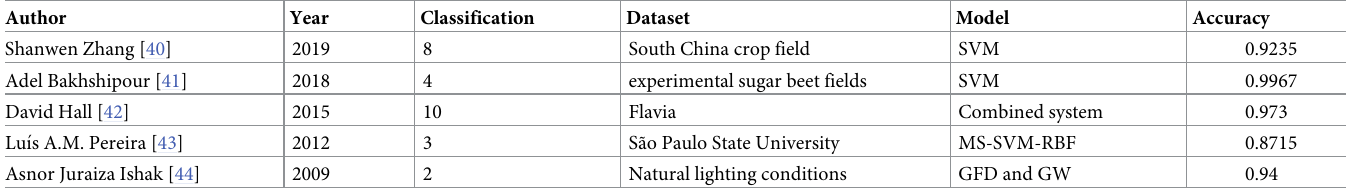
Table 2. Traditional machine learning